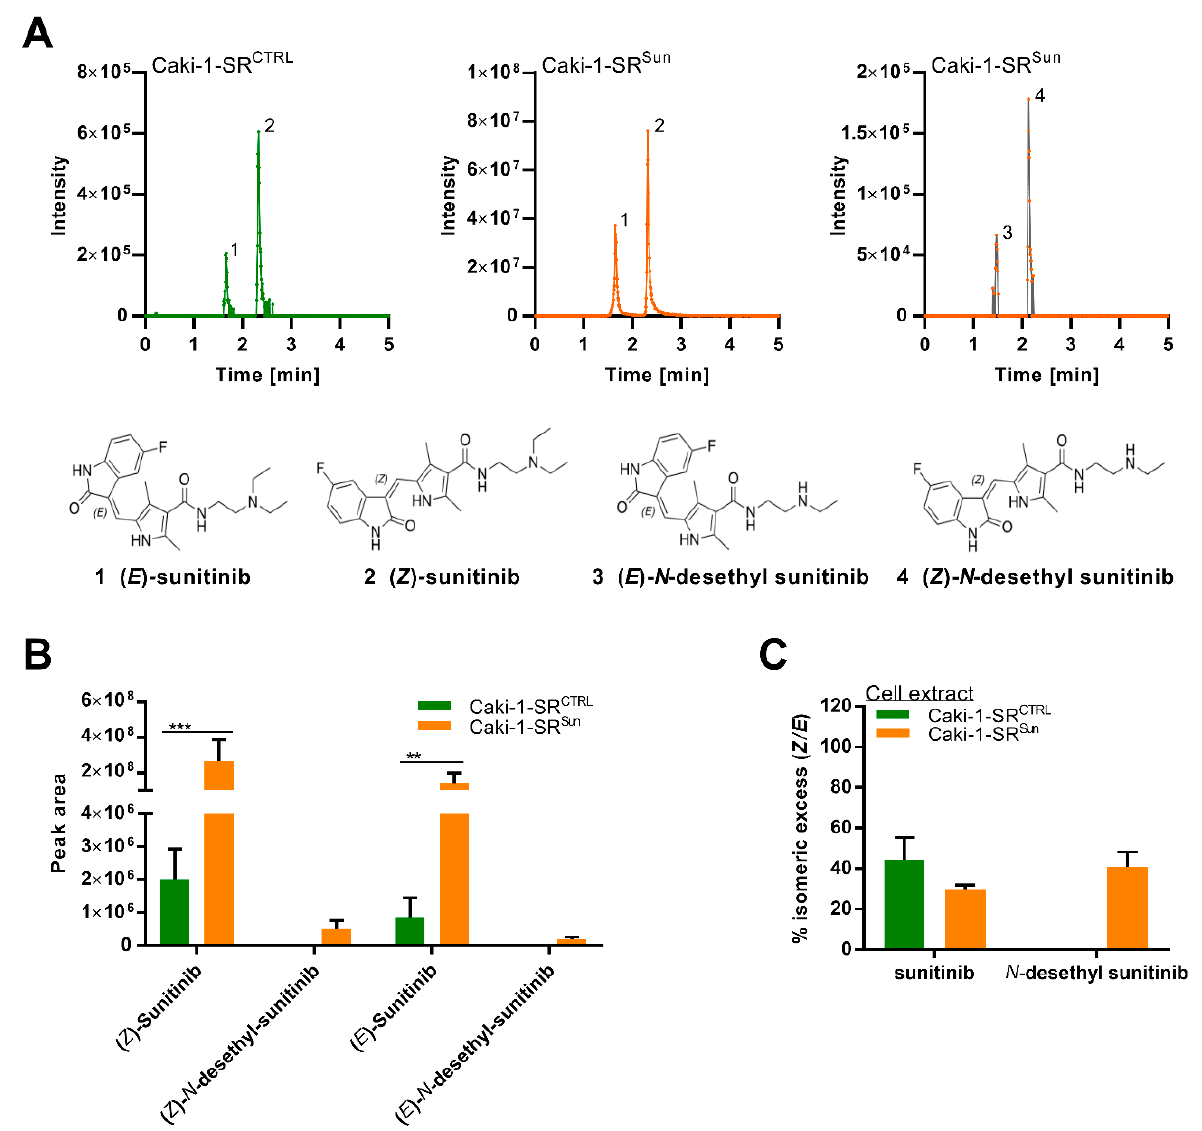
Figure 4. Liquid chromatography-high resolution tandem mass spectrometry analysis of sunitinib-related compounds in Caki-1-SR cells. ( A ) LC-HRMS/MS analysis (base peak intensity chromatograms) of the cell extract of Caki-1-SR in the absence (Caki-1-SR CTRL ) and presence of 1 µM sunitinib (Caki-1-SR Sun ) to demonstrate the presence of the ( E )- and ( Z )-stereoisomers of sunitinib and its N -desethyl metabolites. ( B ) Peak area of sunitinib and (N)-desethyl sunitinib isomers in the extract of Caki-1-SR CTRL and Caki-1-SR Sun ( n = 3). Error bars represent the SD. Statistical significance was calculated by using a two-way ANOVA with unequal variances; ** p < 0.01, *** p < 0.001. ( C ) Bar graphs demonstrating the % isomeric excess ( Z/E ) of the sunitinib isomers and their N -desethyl metabolites in cell extract ( n = 3) of Caki-1-SR cells cultured for 24 h in culture medium (CTRL) or in culture medium supplemented with 1 µM sunitinib.